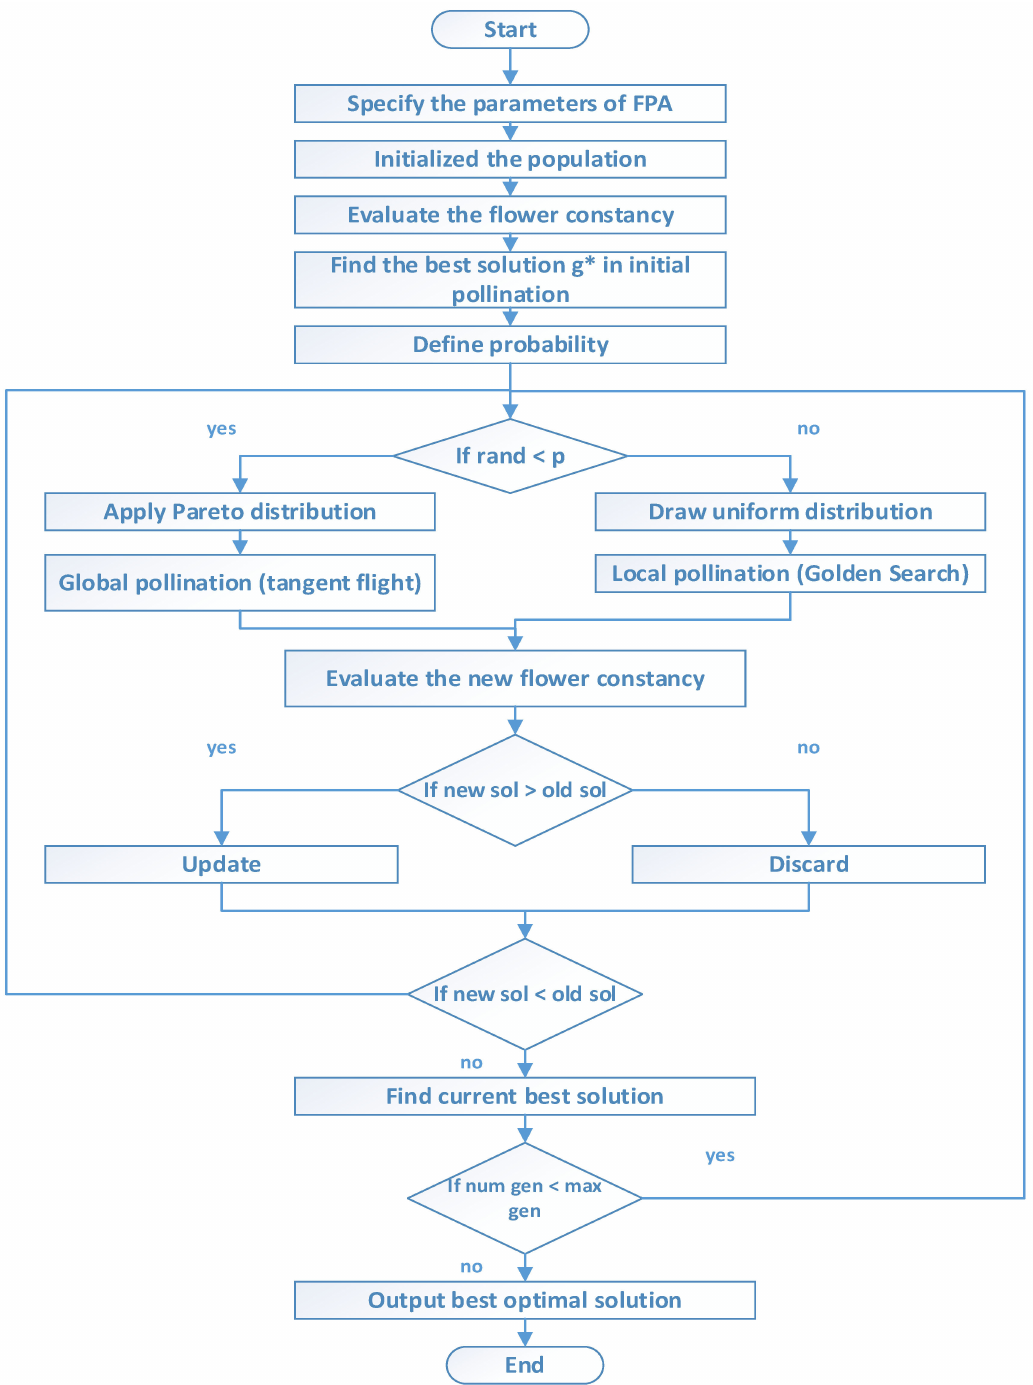
Figure 1. Flow chart of the proposed